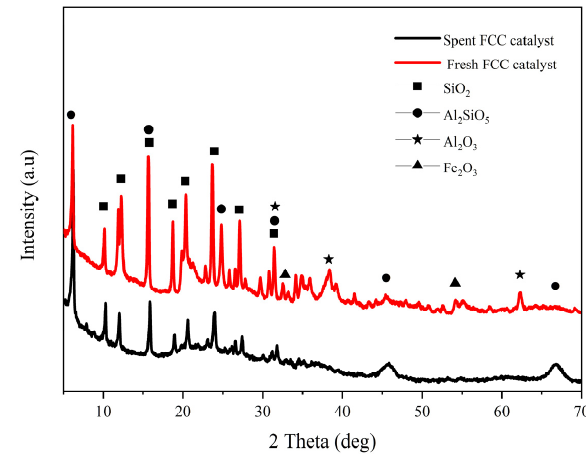
Figure 2. XRD patterns of fresh and SFCC